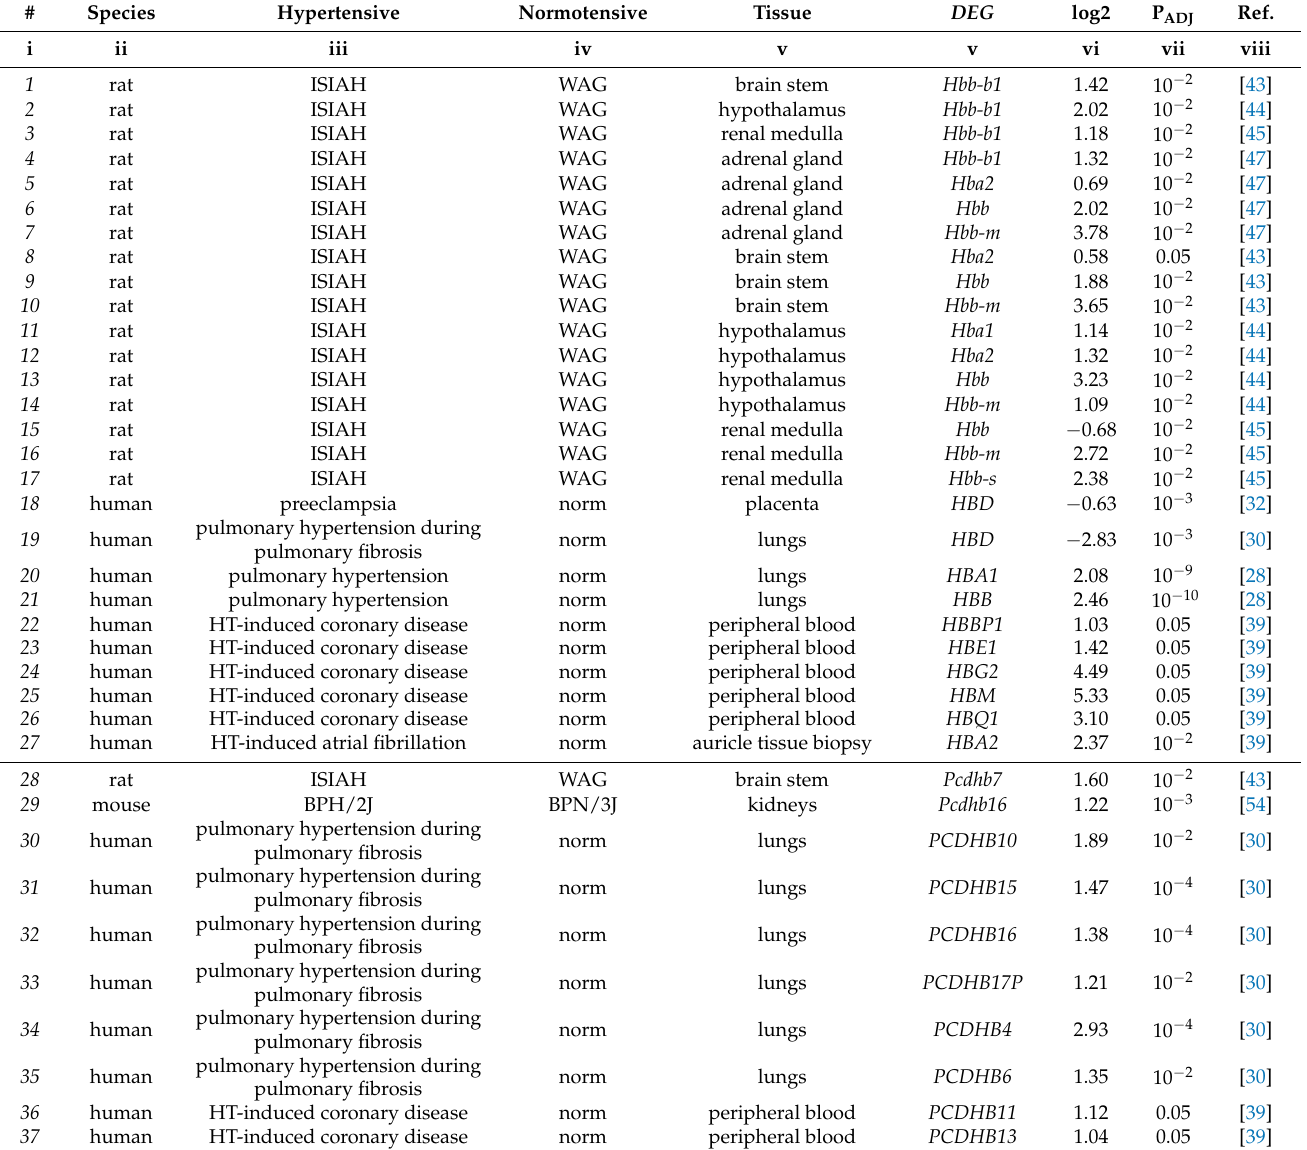
Table 7. Statistically significant upregulation of the hemoglobin subunit and β -protocadherin DEGs— in the tissues of the hypertensive versus normotensive subjects (i.e., patients and animals)—that were for the first time compiled together